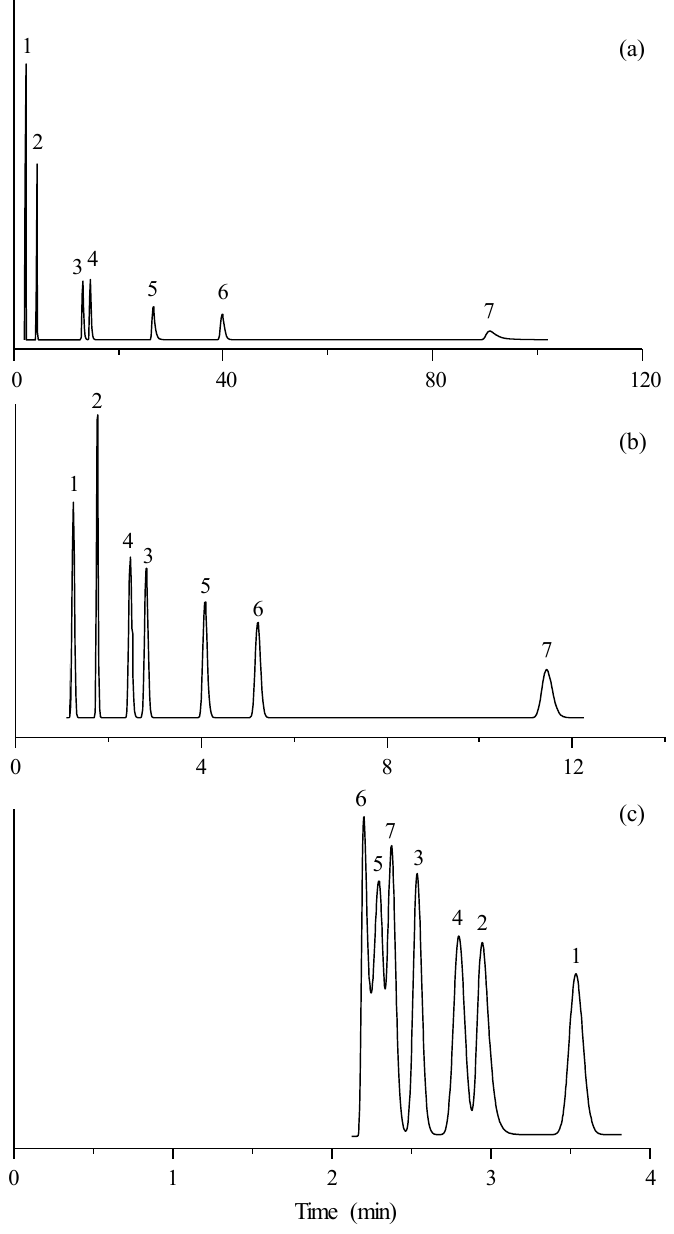
Figure 4. Chromatograms showing maximal resolution for the set of β-adrenoceptor antagonists in (mobile phase composition is given): ( a ) RPLC without additive (13.8% acetonitrile), ( b ) RPLC with IL (17.5% acetonitrile/10 mM [C 6 C 1 im]Cl, and ( c ) HILIC (6.5% water). Compounds: (1) atenolol, (2) carteolol, (3) metoprolol, (4) acebutolol, (5) esmolol, (6) oxprenolol, and (7) propranolol. Detection wavelength was 254 nm, at which timolol does not absorb.